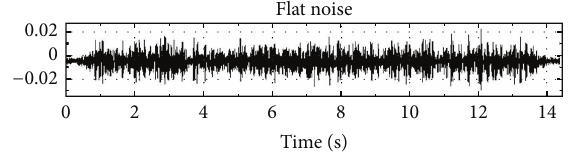
Table 12: Peak value of acceleration